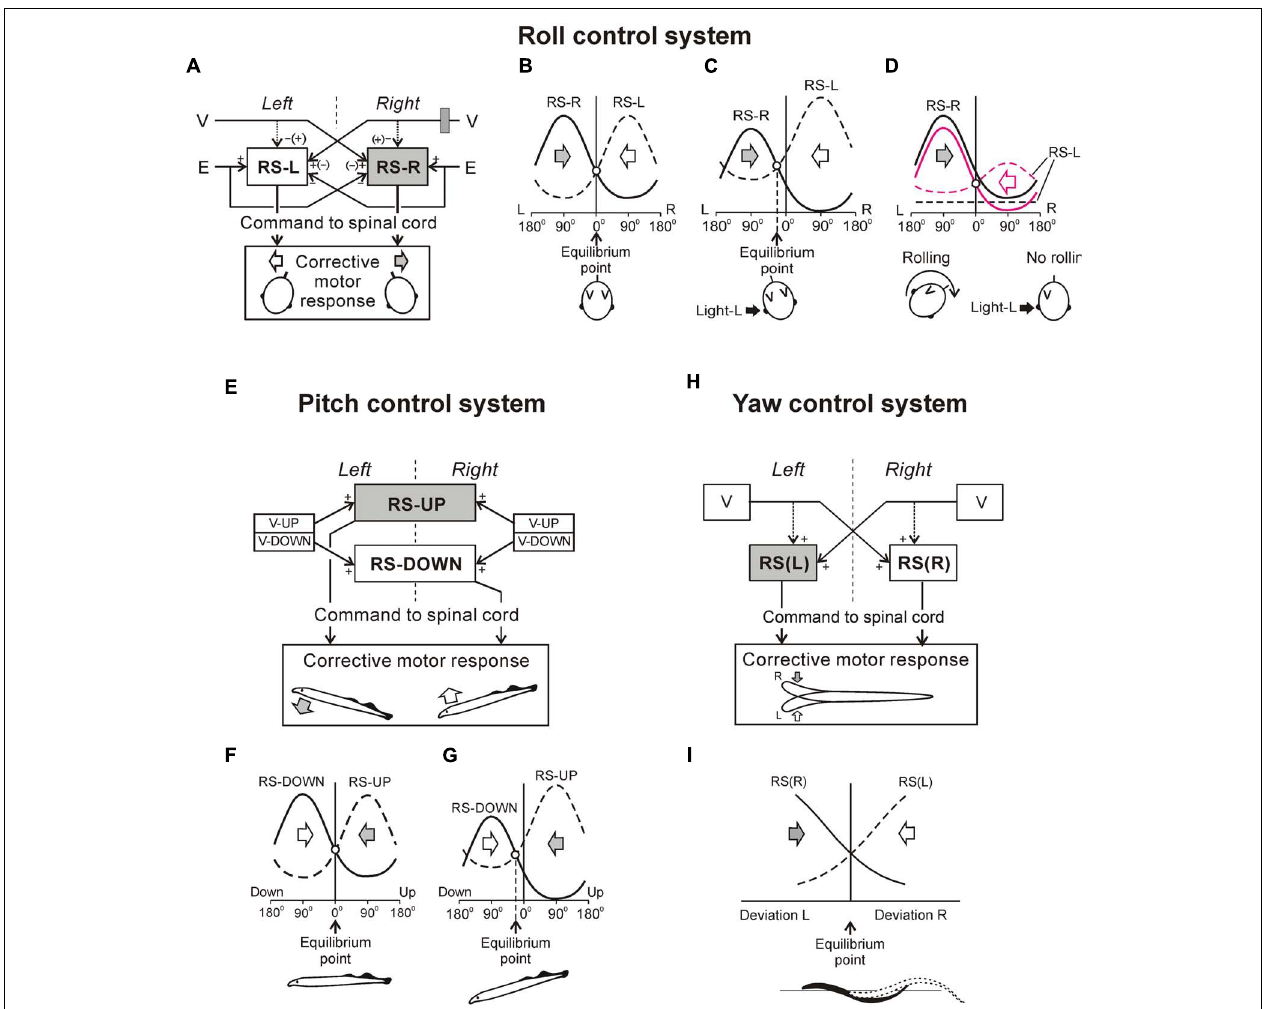
FIGURE 5 | Conceptual models of systems controlling orientation in different planes. (A–D) Roll control system. (A) Two groups of RS neurons (RS-L and RS-R) receive inputs from the labyrinths (V) and eyes (E); they affect the spinal networks to evoke rolling of the lamprey. The signs ( + and –) indicate the major effects on RS neurons produced by sensory inputs, the signs in brackets – the minor effects. (B) Operation of the system when driven only by vestibular inputs. The curves represent activity in RS-R and RS-L as a function of roll angle (L, left tilt; R, right tilt). Vestibular input causes activation of RS-R and RS-L with the contralateral tilt. Direction of rolling caused by RS-R and RS-L is indicated by the gray and white arrows, respectively. The system has an equilibrium point at 0 ◦ (dorsal-side-up orientation). (C) Operation of the system when the left eye is illuminated. This visual input (a black arrow; Light-L) causes a shift of the equilibrium point to the left and the corresponding tilt of the animal. (D) Effect of the right unilateral labyrinthectomy (indicated by gray rectangle in A ). The RS activity after the right labyrinthectomy is shown by black solid and interrupted lines. The system has no equilibrium point and the animal continuously rolls to the right. Rolling could be abolished by means of left eye illumination causing activation of RS-L and some inactivation of the RS-R (shown by red interrupted and solid lines, respectively) resulting in re-creation of the equilibrium point. (E–G) Pitch control system. (E) Two groups of RS neurons, RS-UP and RS-DOWN, receive excitatory inputs from vestibular afferents activated by nose-up (V-UP) and nose-down (V-DOWN) pitch tilt, respectively. Each of the RS-UP and RS-DOWN groups sends a command to the spinal cord